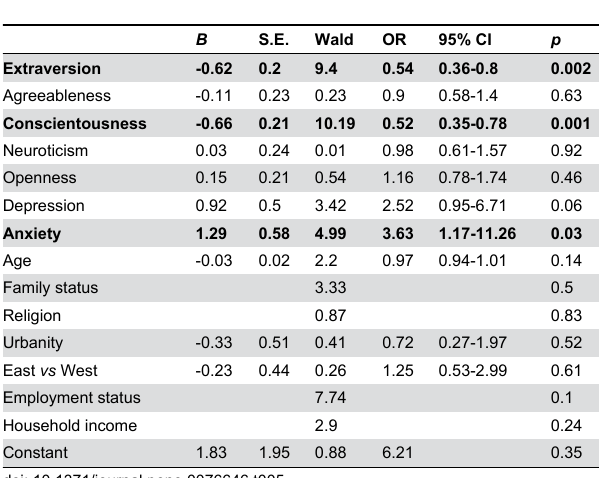
Table 5. Logistic regression analysis of suicide risk for males